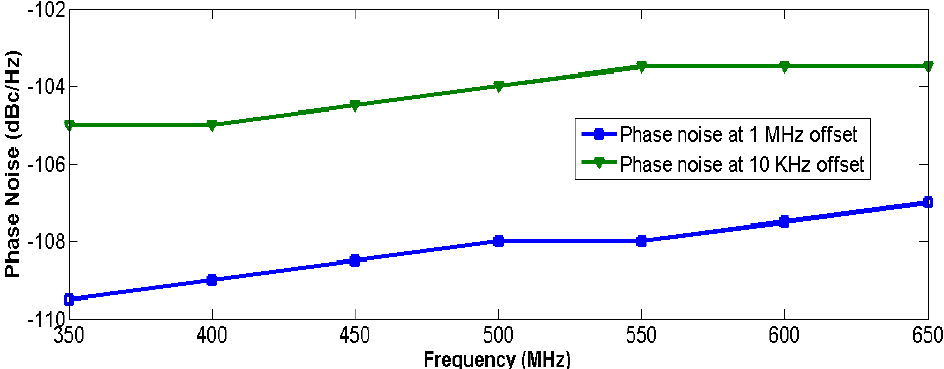
Figure 10. Measured phase noise at different offset frequencies.